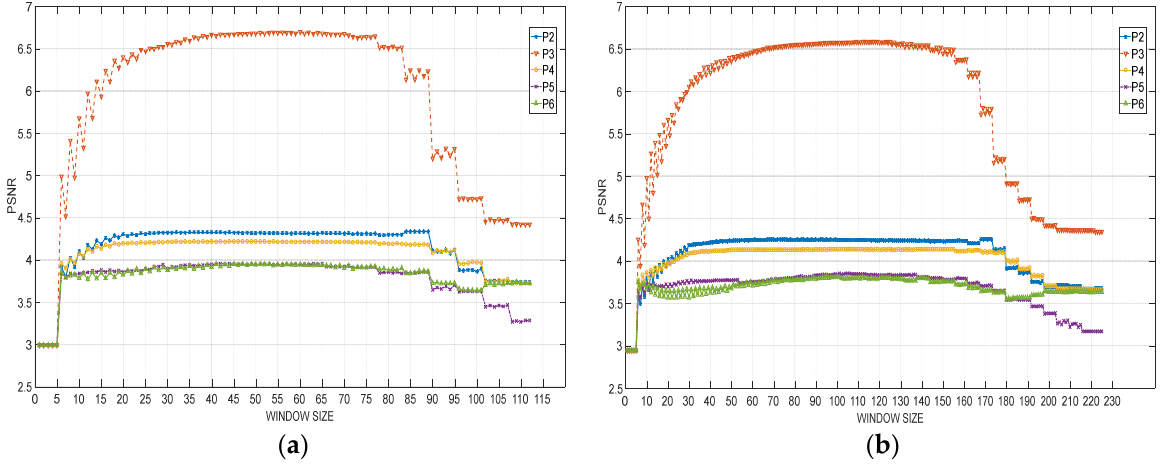
Figure 9. PSNR value curves of five samples in the same size: ( a ) 300 × 300; ( b ) 450 × 450. When the size of the sample is 450 (cid:3400) 450 , the middle dark module is close to 45 (cid:3400) 45 . While the dark modules are near 90 (cid:3400) 90 in the 900 (cid:3400) 900 samples. From